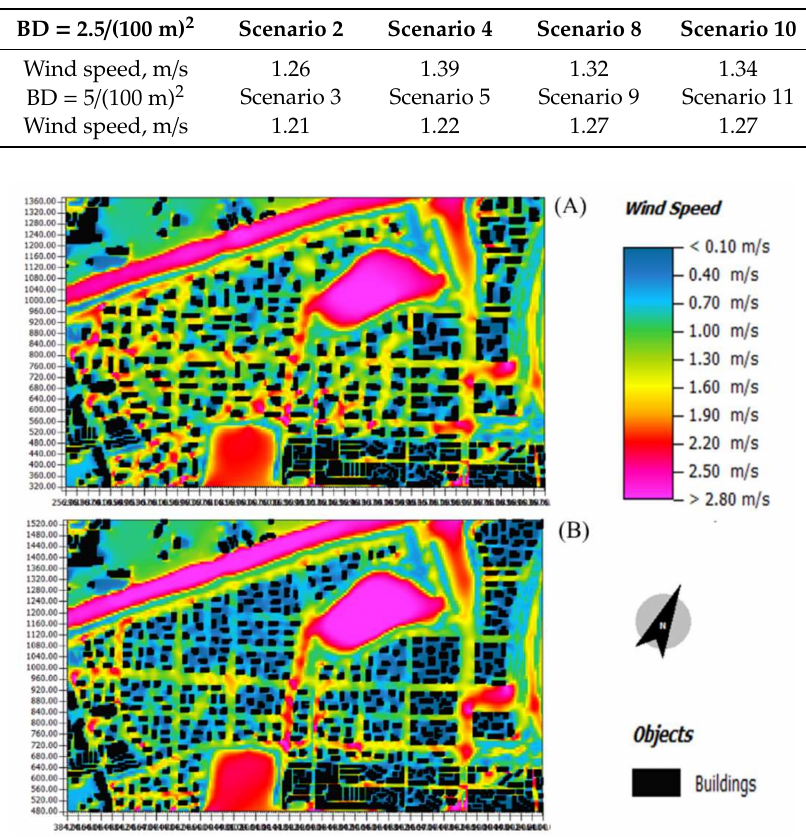
Figure 12. Distribution of simulated wind speeds in Scenario 2 ( A ) versus Scenario 3 ( B